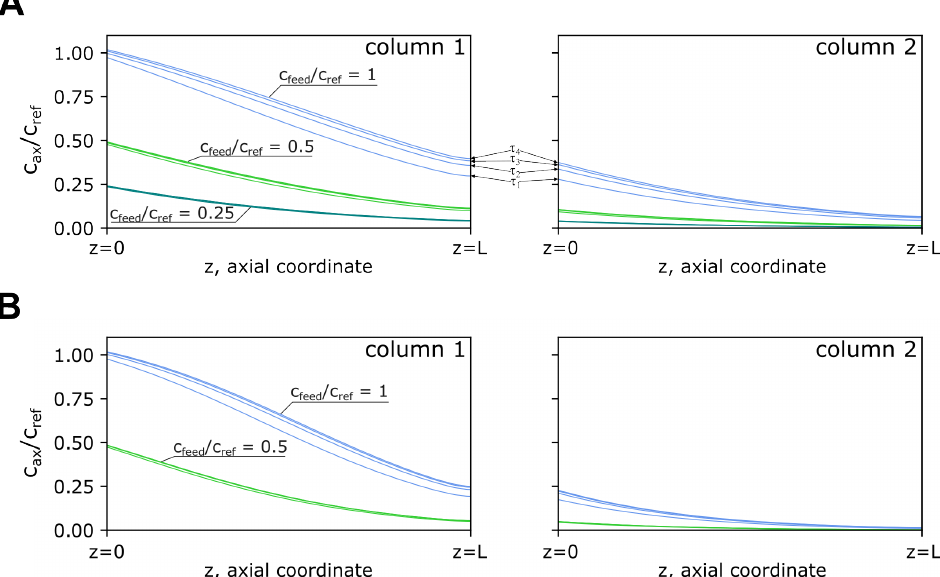
Figure 4. Axial concentration profiles of the 4C-PCC loading zone: simulations using a load flow-rate − 1 − 1 of ( A ) 0.51 mLmin and ( B ) 0.33 mLmin ; c ax , c ref , and c feed are the axial, reference, and feed − 1 concentrations, respectively; c feed used 2, 1, and 0.5 × 10 12 TPmL , while the axial concentration profiles of the loading zone were calculated at the end of each switching interval ( τ ) composing the first cycle of the 4C-PCC process. The scenario of c ref /c feed = 0.25 was not represented for the flow − 1 rate of 0.33 mLmin , as the axial profile did not reach the column 1